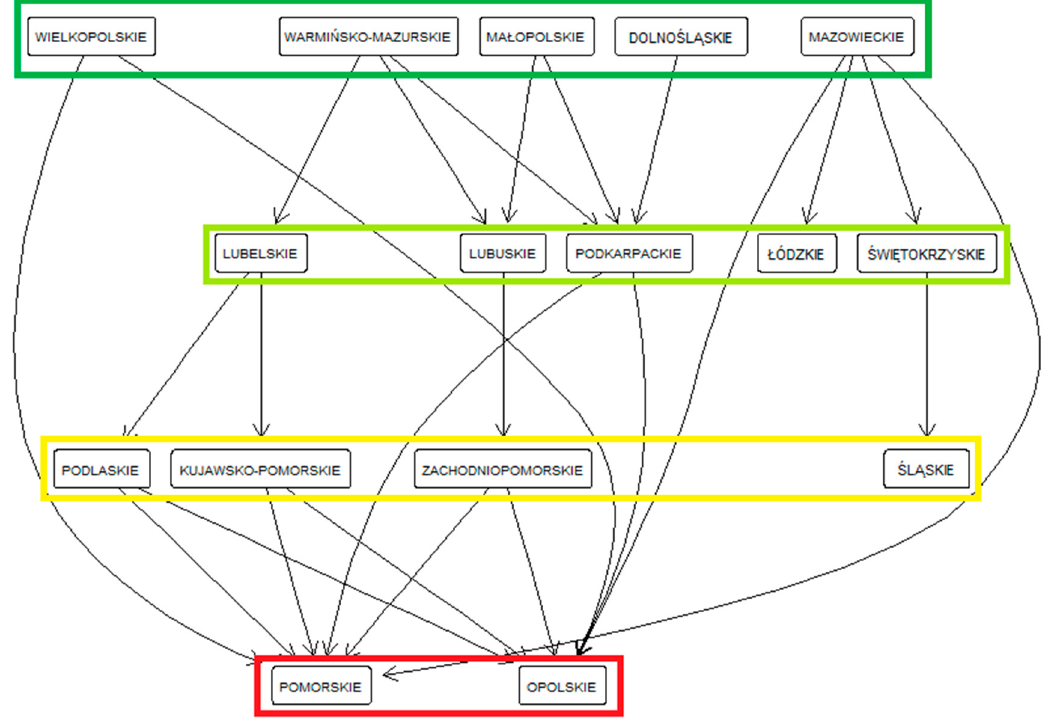
Figure 2. Partial ranking of voivodeships in terms of biogas and biomass efficiency in 2018.